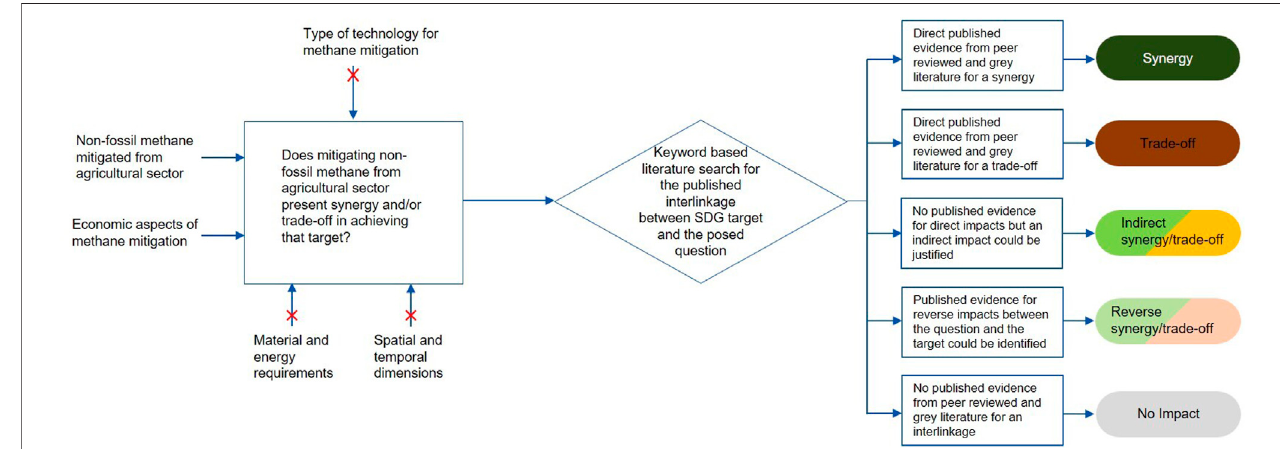
FIGURE 1 | The fl owchart of methodology with the system and its